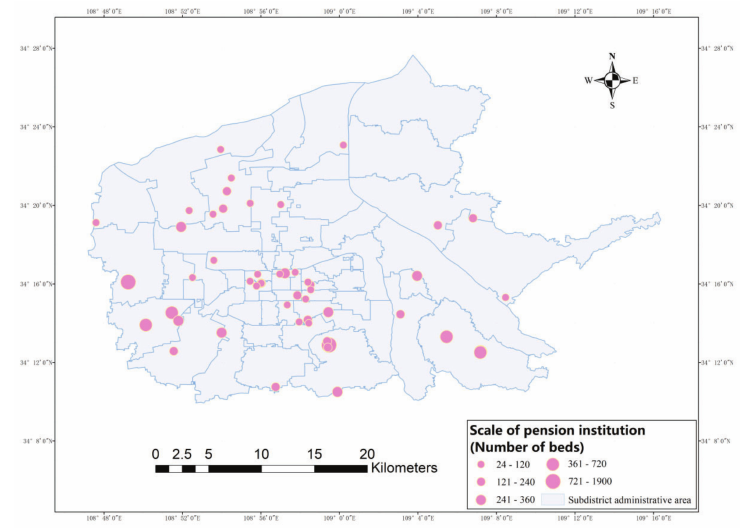
Figure 4. Facility